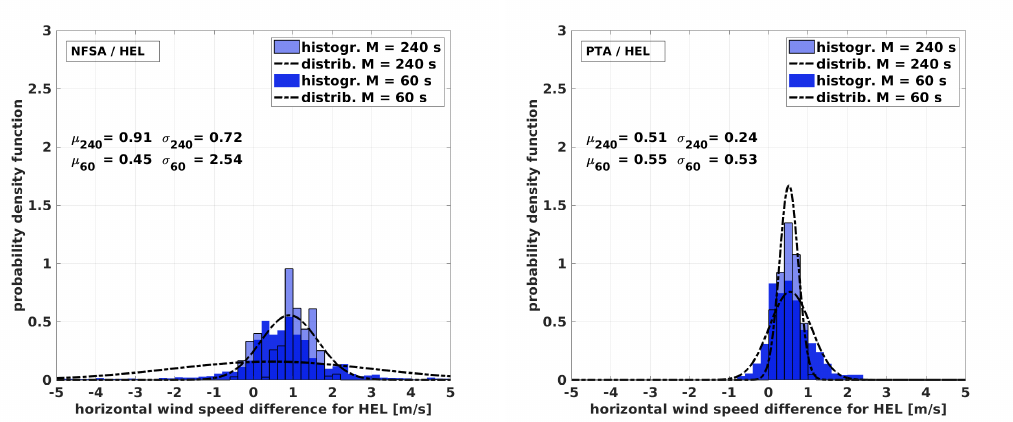
Figure 16. Normalized distribution and probability density function with the fitted normal distribution for the flight in Helgoland ( HEL ). The plots show the deviation between the MHPA and the NFSA ( left ) and the MHPA and the PTA ( right ) for M = 240 s and for M = 60 s.